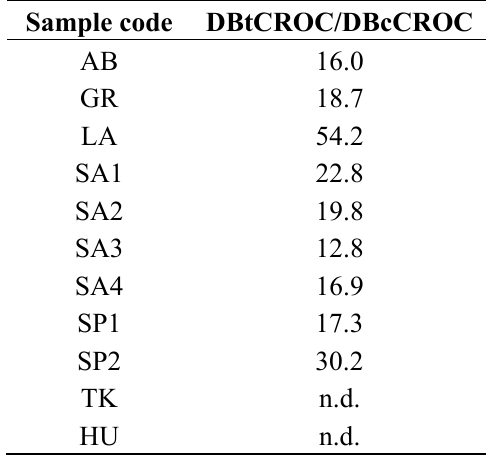
Table 3. Medium DBtCROC/DBcCROC